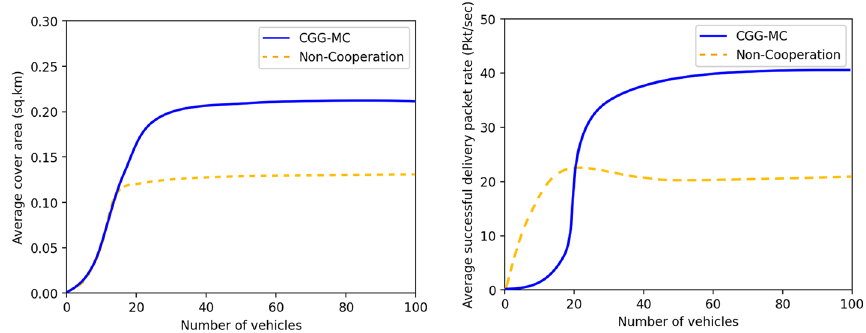
Fig. 10 Average coverage area and average successful packet delivery